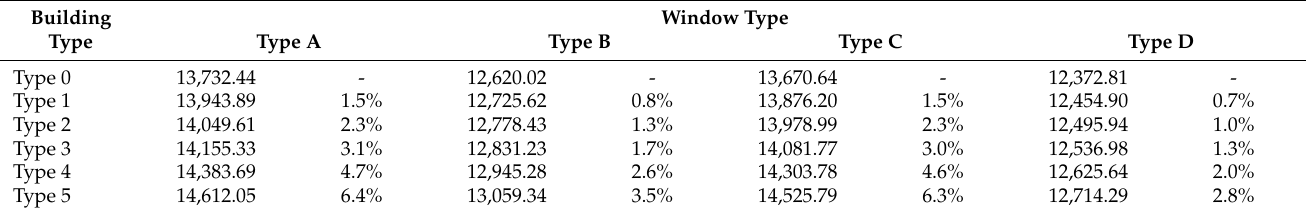
Table 9. Heat gain values by conduction for Erzurum.